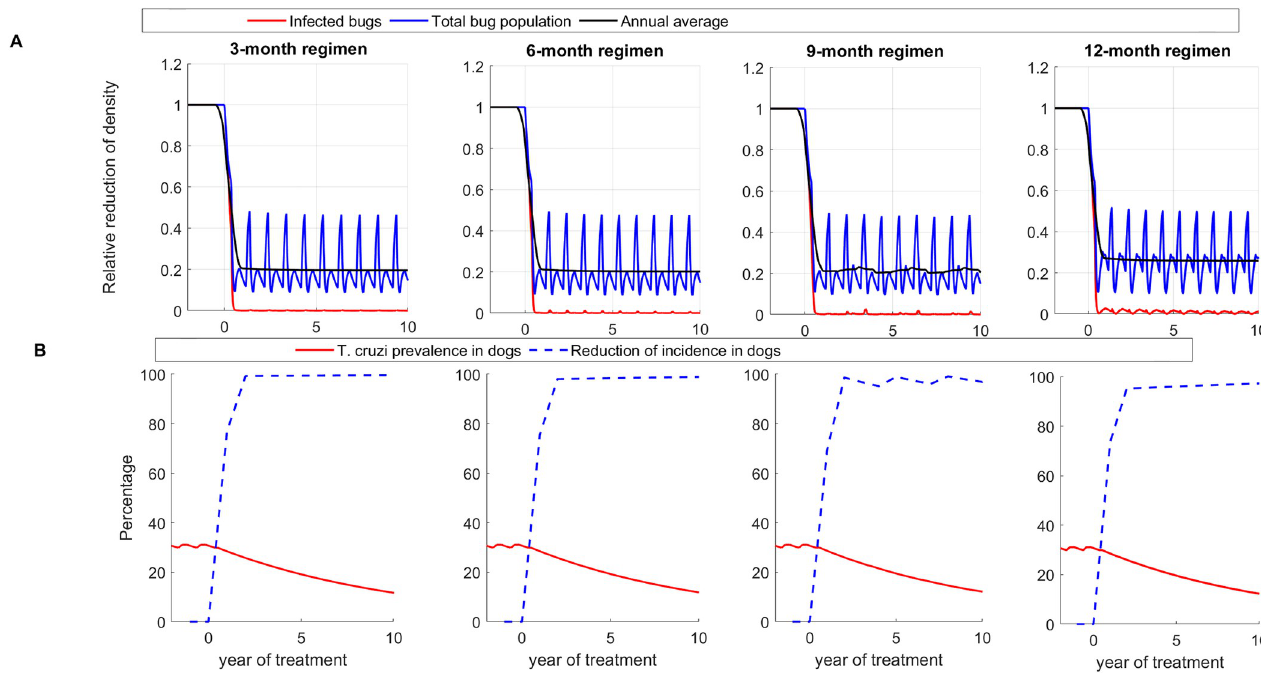
Fig 5. Effectiveness of systemic insecticide treatment of dogs with fluralaner for the control of canine Chagas in a high transmission setting with 3-month, 6-month, 9-month, and 12-month treatment regimens using Model 2. (A) Reduction of total population density (blue) and T . cruzi infections in triatomines (red), (B) Reduction of T . cruzi infection prevalence (red) and incidence in dogs (blue). Effectiveness is evaluated using the single vector-host model with seasonality.